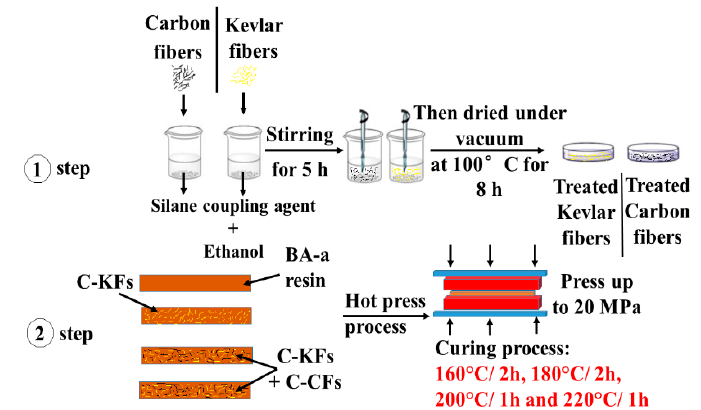
Figure 1. Preparation steps used for the elaboration of the hybrid composites. Table 2. Neat and hybrid formulations investigated with different weight ratios.